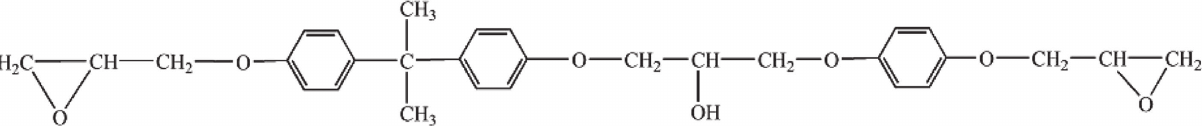
Figure 2: Molecular formula of bisphenol A epoxy